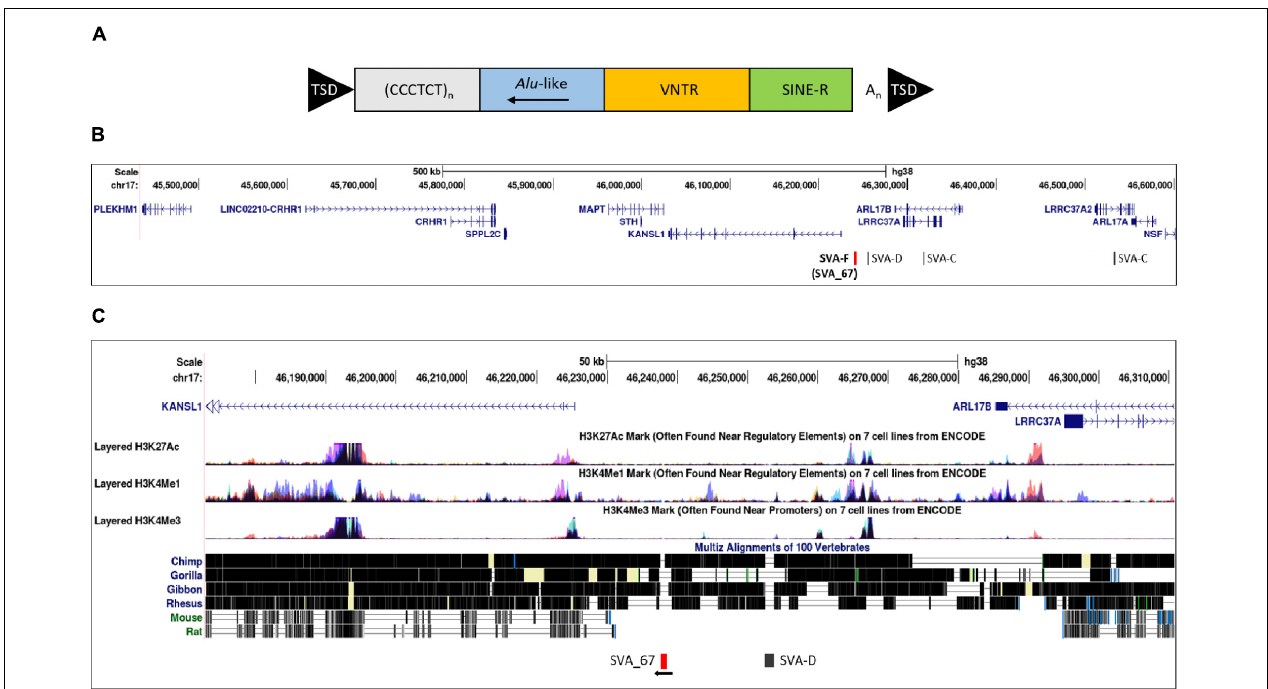
FIGURE 1 | Structure of a full-length SVA and schematic representation of the location of SVA_67. (A) A typical SVA element (full-length) contains five domains. Considered 5 (cid:48) –3 (cid:48) , SVAs are composed of a (CCCTCT) n hexamer repeat, an inverted Alu -like region, a GC-rich variable number tandem repeat (VNTR), a SINE-R domain and a poly A-tail. SVA elements are flanked by target site duplications (TSDs). (B) Schematic modified from UCSC genome browser hg38 of the MAPT locus on chromosome 17. This locus contains multiple genes and four SVAs including the SVA_67 RIP (red bar). Six genes ( MAPT , KANSL1 , CRHR1 , LRRC37A , PLEKHM1 and ARL17A ) were selected for analysis. SVA_67 (chr17:46,237,519–46,238,226) is anti-sense with respect to the orientation (defined as their 5 (cid:48) TSS) of the LRRC37A , CRHR1 and MAPT gene, and shows a sense orientation relative to the KANSL1 , ARL17A and PLEKHM1 gene. (C) ENCODE data from UCSC showing the levels of enrichment of histone marks in proximity of SVA_67. Signals for H3K27Ac (marker of active regulatory domains associated with active enhancer elements), H3K4Me1 (marker of regulatory domains associated with enhancers) and H3K4Me3 (marker of a regulatory domains associated with promoters) are indicated. The region has been overlaid with a conservation track of several primates and rodents which shows that SVA_67 is human